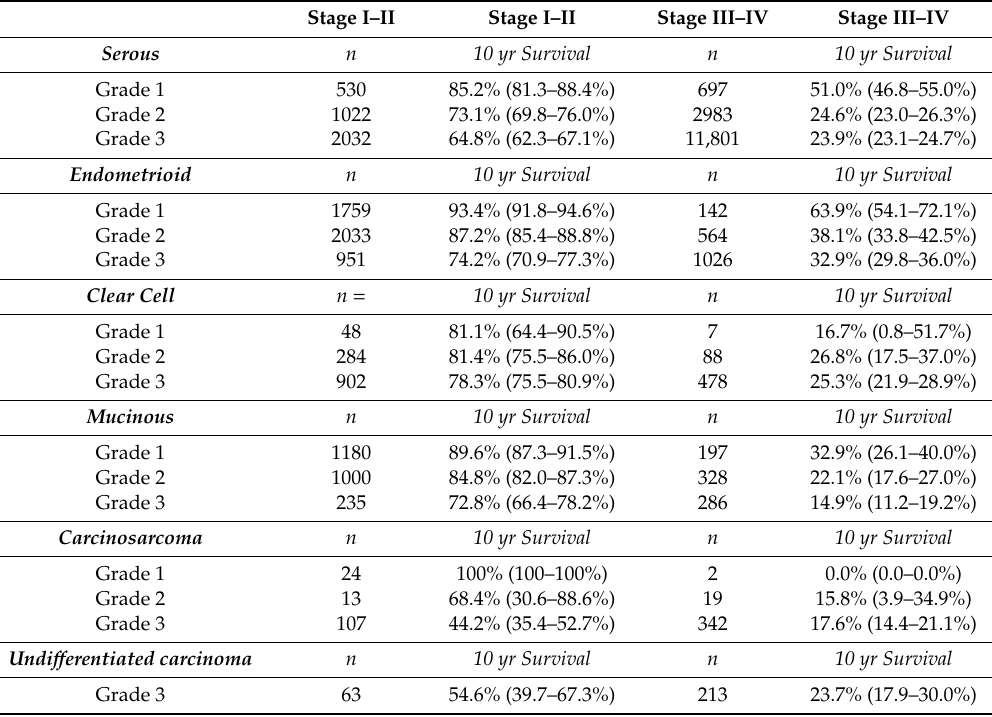
Table 1. EOC sub-types by stage and grade taken from KM